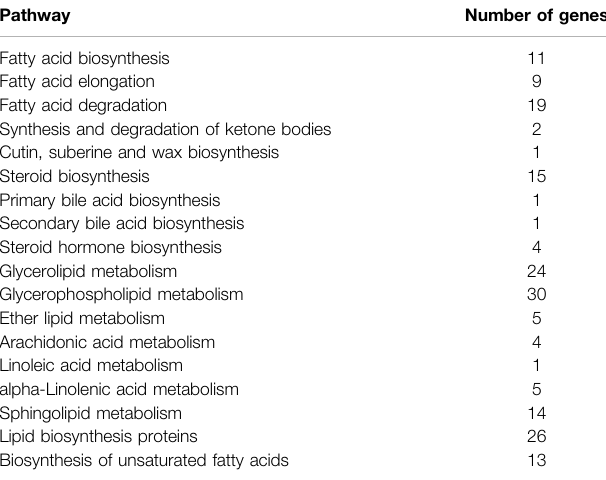
TABLE 1 | KEGG pathway enrichment analysis of lipid metabolism in GXDK6.